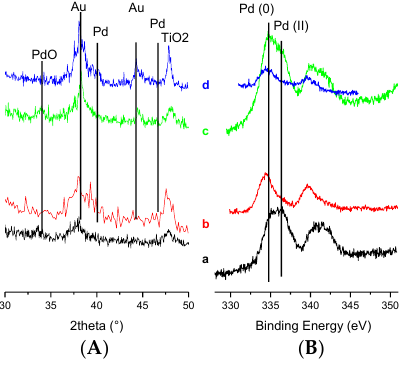
Figure 9. XRD ( A ) and Pd 3d XPS ( B ) spectra of 2Pd2AuTiSBA fresh (a) and spent (b) and 2Pd2AuTiHMS fresh (c) and spent (d).